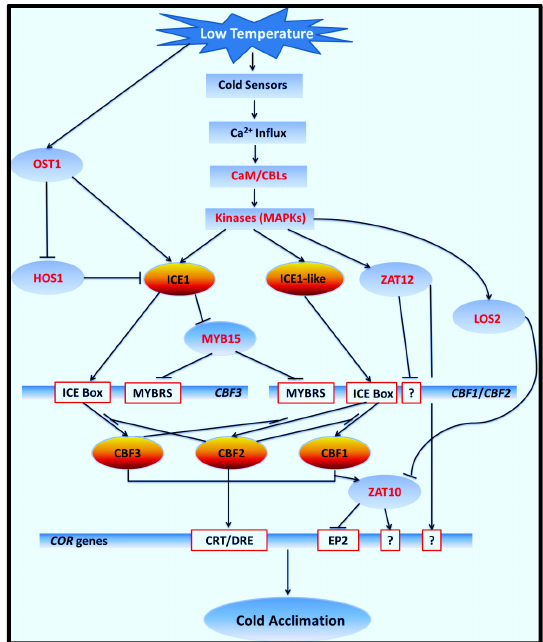
Figure 9. Diagram of cold ‐ responsive regulatory networks [8,14]. The arrows indicate activation, whereas lines ending with a bar indicate negative regulation; the “?” indicates unknown